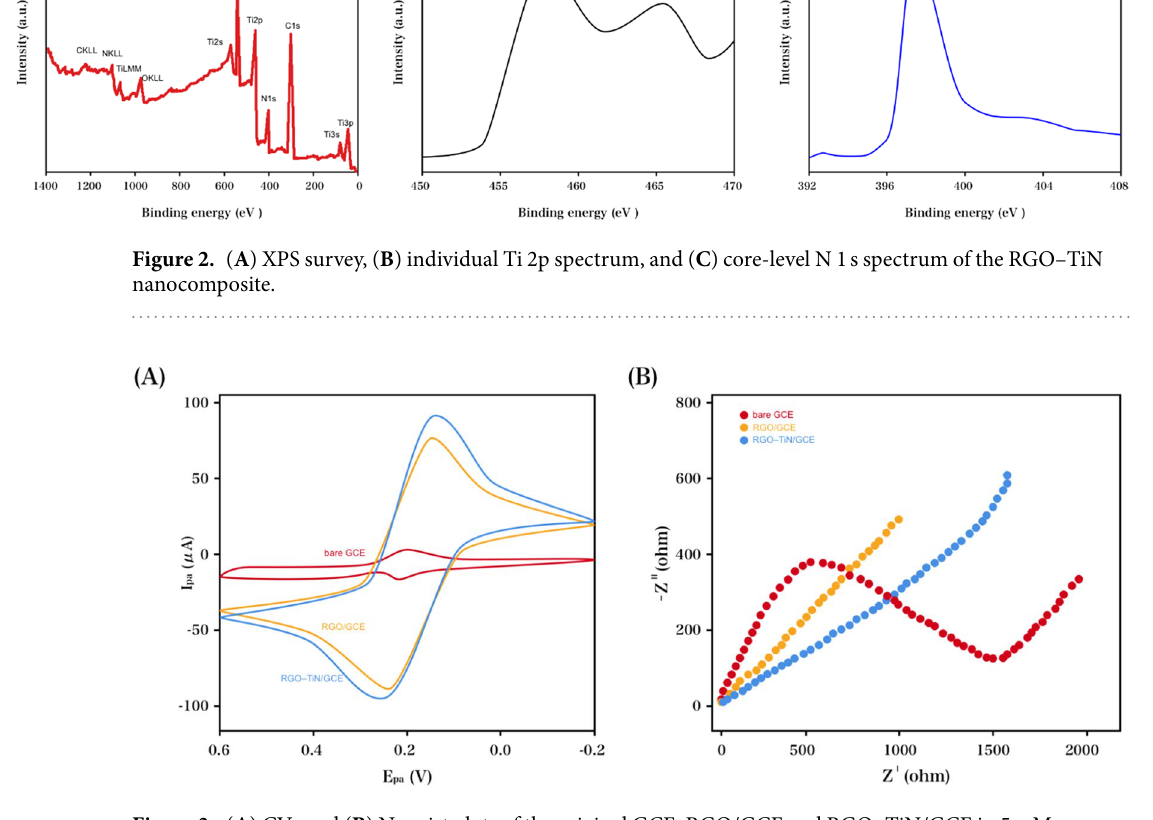
Figure 3. ( A ) CVs and ( B ) Nyquist plots of the original GCE, RGO/GCE and RGO–TiN/GCE in 5 mM Fe(CN) 63 − /4 − (1:1) solution containing KCl (0.1